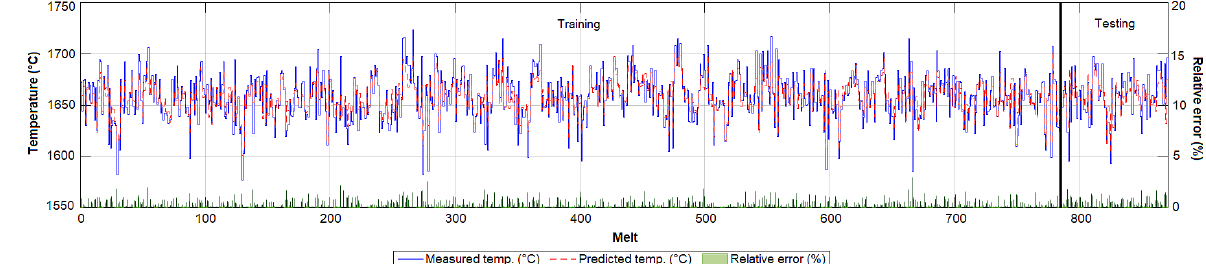
Figure 6. Prediction of endpoint melt temperature by SVR model with the Gaussian kernel.